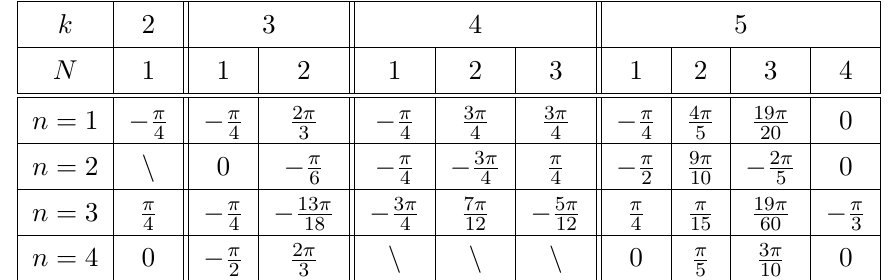
Table 2 . The exact values of b = 1 . Only the values that are related to the duality are included here. The absolute values of the matrix models with Chern-Simons level k and − k are the same as in (3.6). This table shows that the well-known level-rank duality holds for absolute value. We also numerically checked that (cid:12) i(cid:12) h ˜ Z (cid:12) (cid:12) U ( k ) = 1 . (cid:12) (cid:12) k, 0